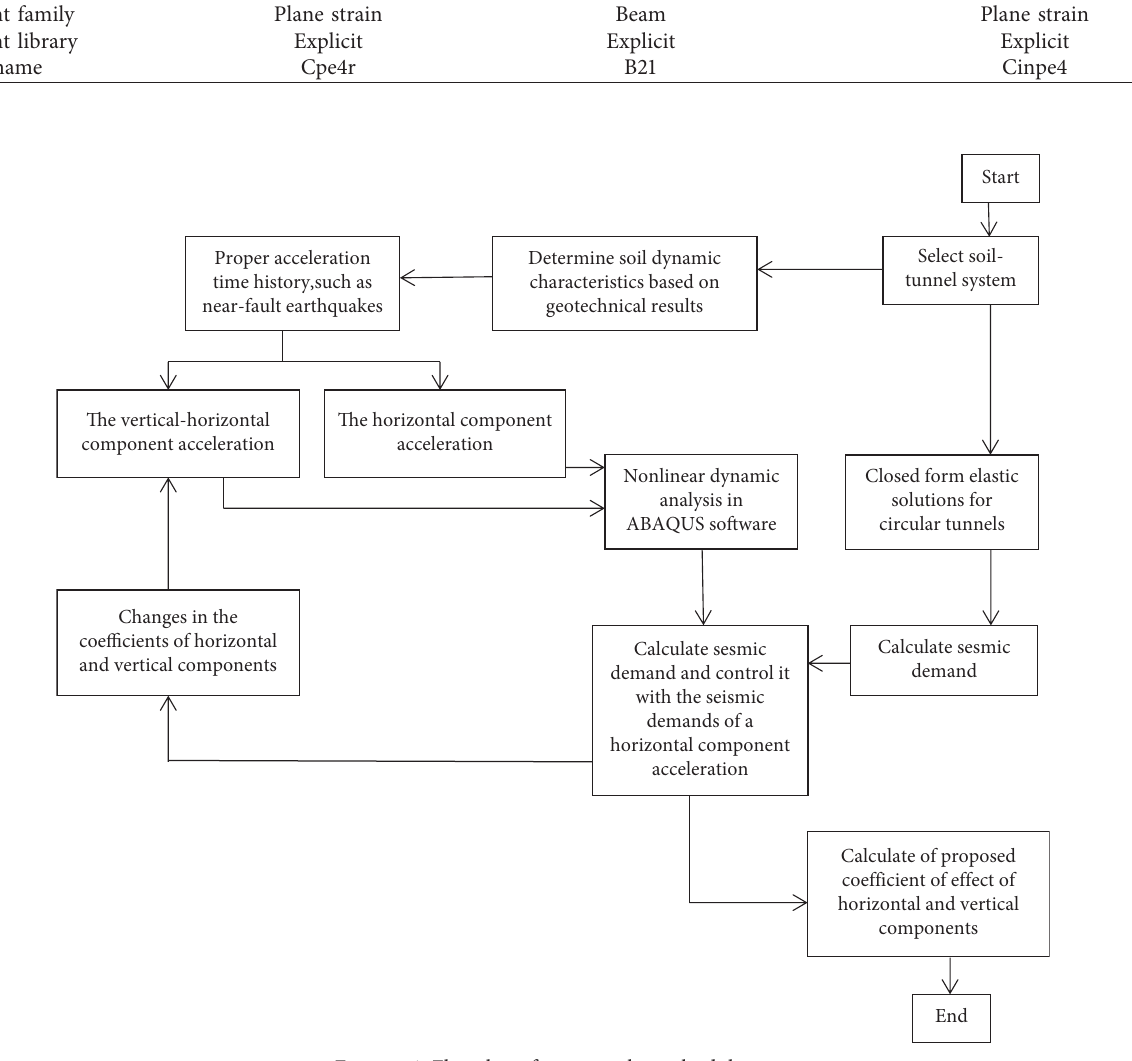
Figure 6: Flowchart for research